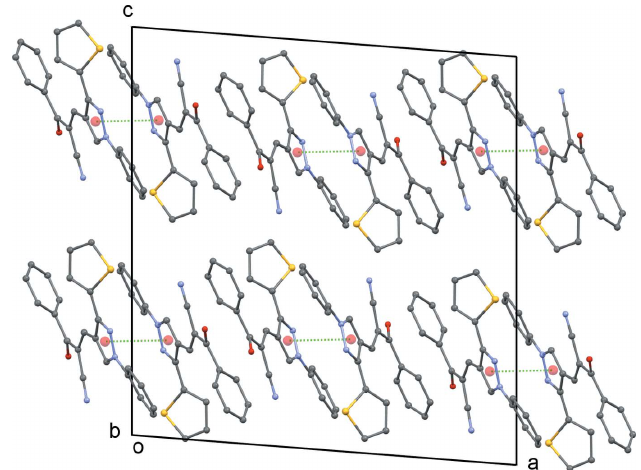
Figure 2 A packing diagram viewed along the b axis. (cid:2) – (cid:2) interactions are shown as dotted lines.